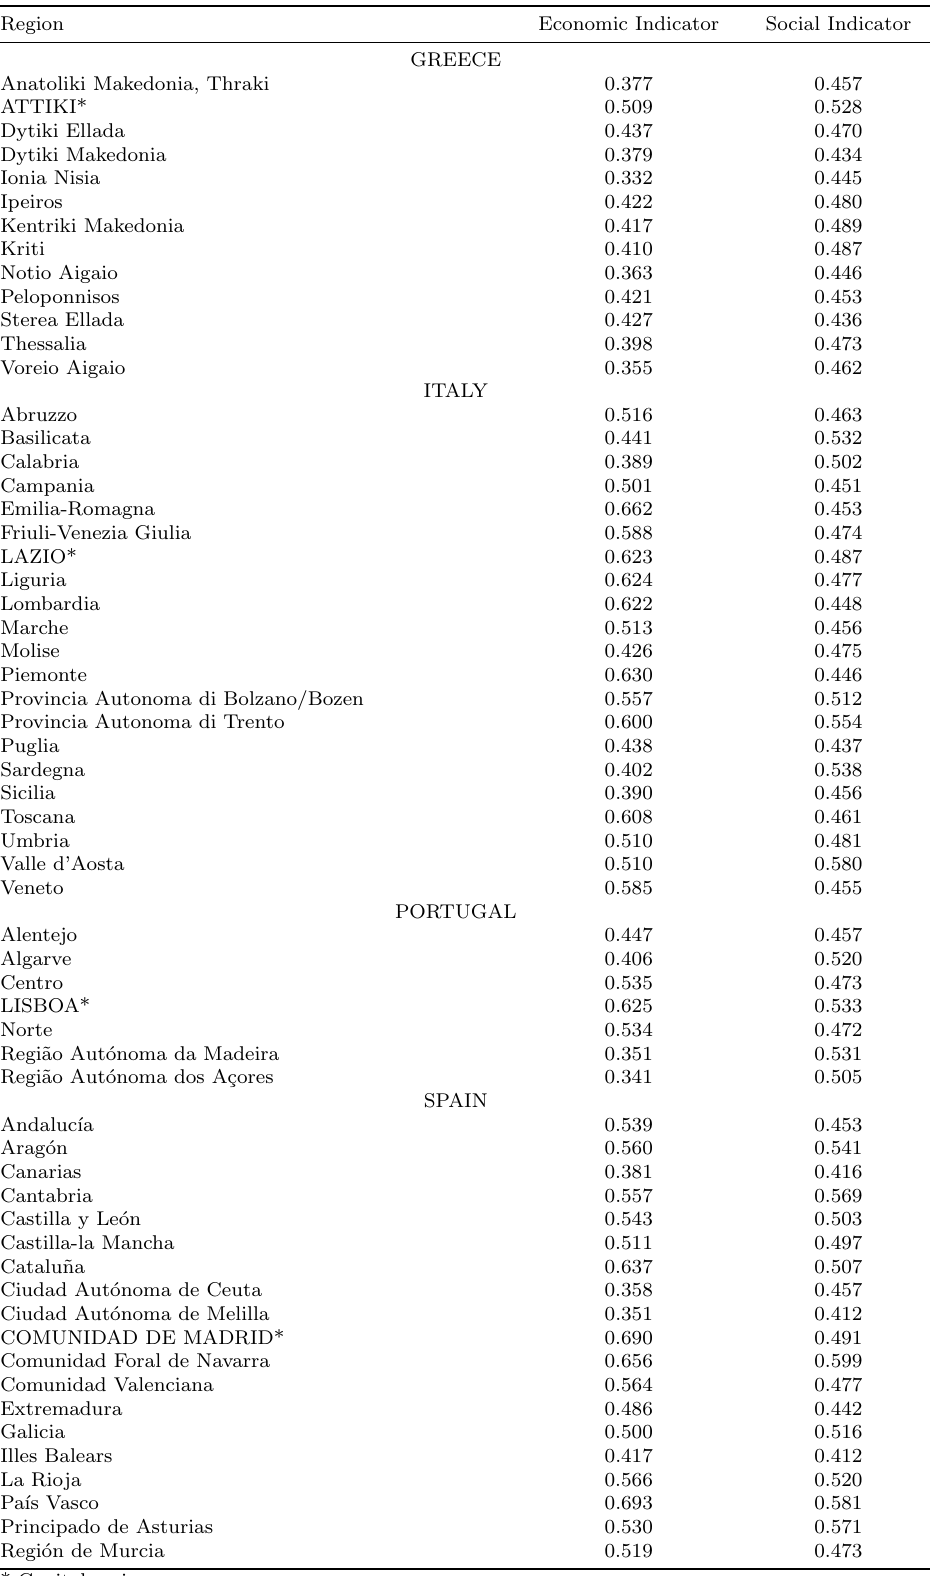
Table A.1: The values of the Economic and the Social Indicators of the south European